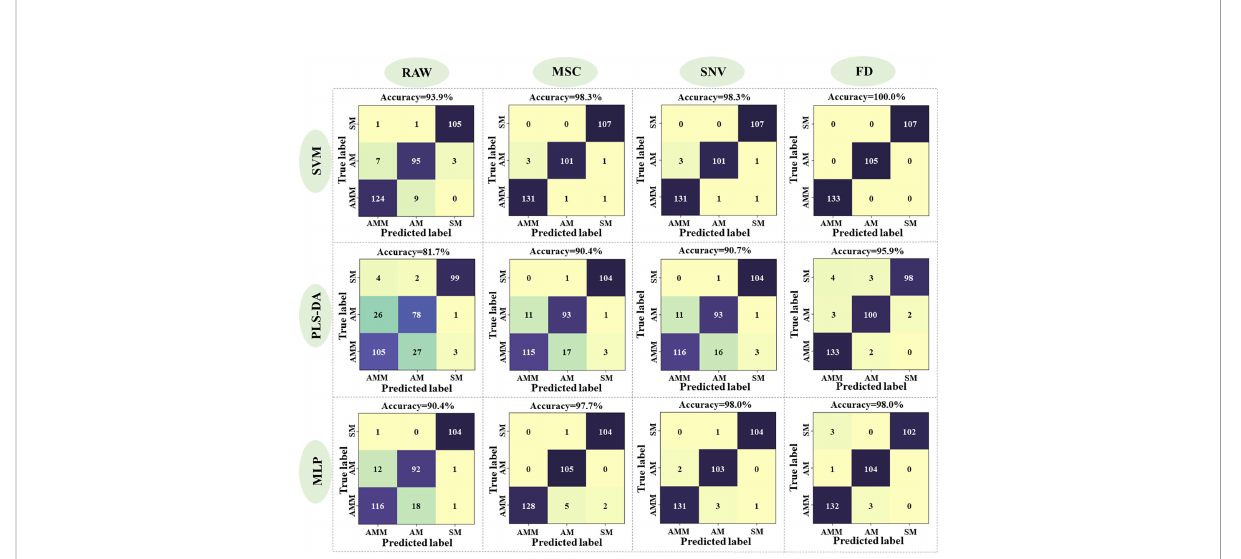
FIGURE 5 Accuracy of SVM, PLS-DA, and MLP models with spectral data that was preprocessed or